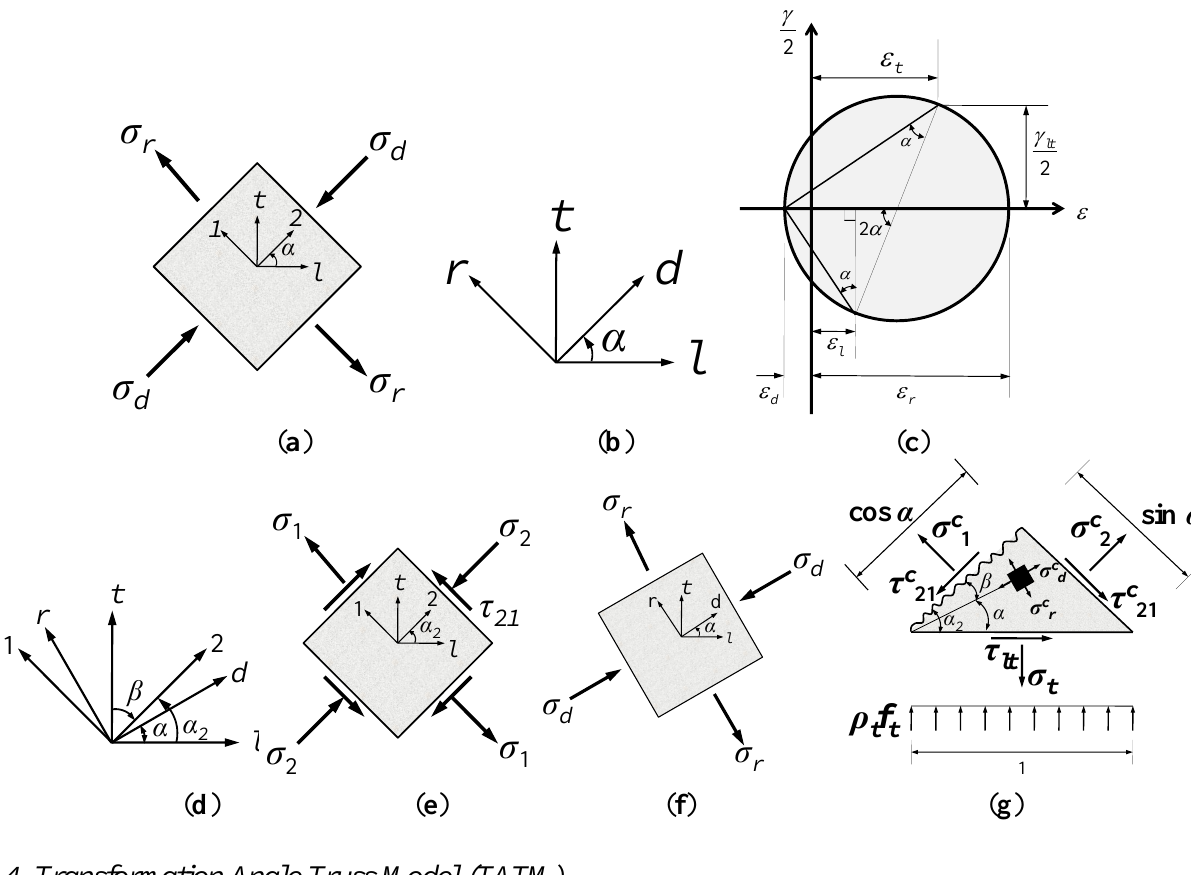
Figure 2. Notations for various softened truss models. ( a ) Stresses in RA-STM; ( b ) Angles in rotated angle model; ( c ) Mohr’s strain circle; ( d ) Angles in fixed angle model; ( e ) Stresses at crack direction; ( f ) Stresses at principal direction; (g) Stresses and direction of angles in the transformation angle truss model (TATM).